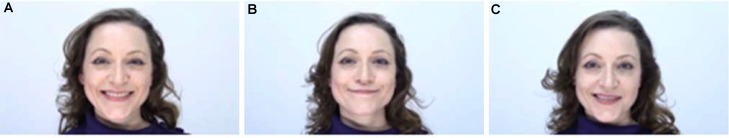
Example of a reward smile (A), affiliative smile (B), and dominance smile (C) at the peak intensity of the display.